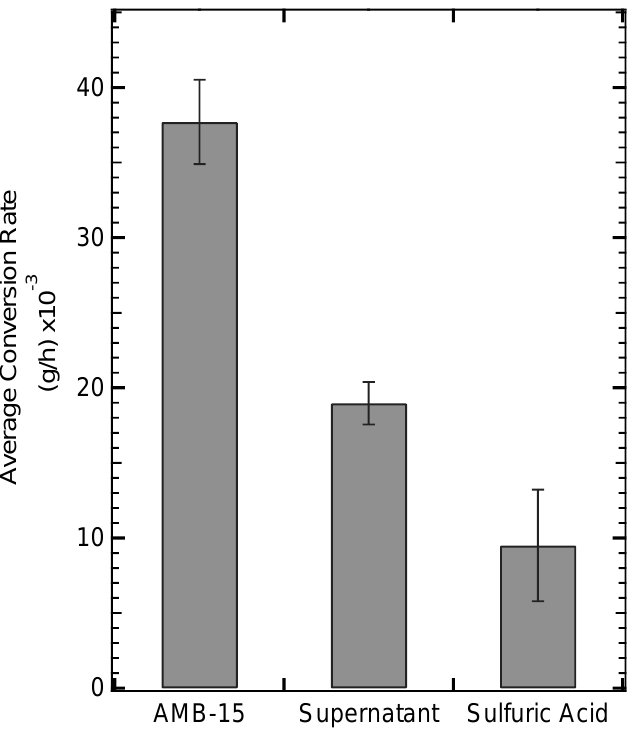
Figure 4. Comparison of the average glucose conversion rates after glucose dehydration with fresh solid acid catalyst, its supernatant, and sulfuric acid. The supernatant was generated by treating AMB-15 at the same conditions as the glucose dehydration reaction. Sulfuric acid at the equivalent concentration (pH = 2.94) to that of the supernatant was used as a control. Conditions: 150 °C (±2.5 °C) reaction temperature and 2 h reaction time, 2 mL of water, 0.1 g of glucose, and 0.2 g of catalyst.